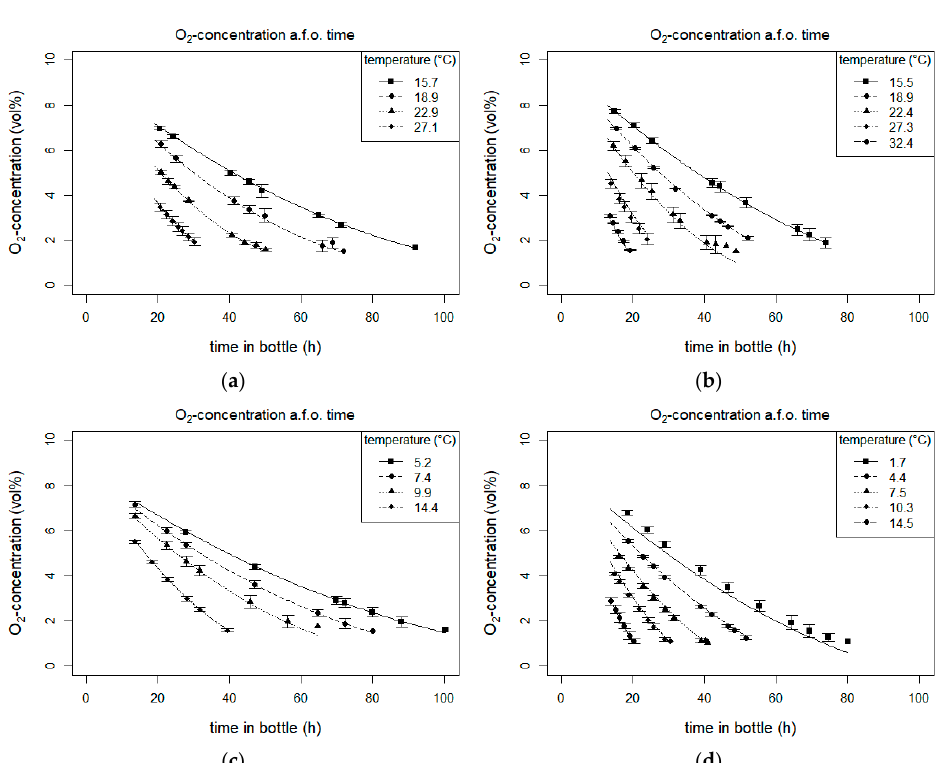
Figure 1. O 2 concentration as a function of time for the different temperatures. Lines: fitted values per storage temperature based on the fixed effects; dots: mean of measured values; whiskers: standard deviation of measured values. ( a ) Phalaenopsis February; ( b ) Phalaenopsis March; ( c ) Chrysanthemum cv. B; ( d ) Chrysanthemum cv. C.